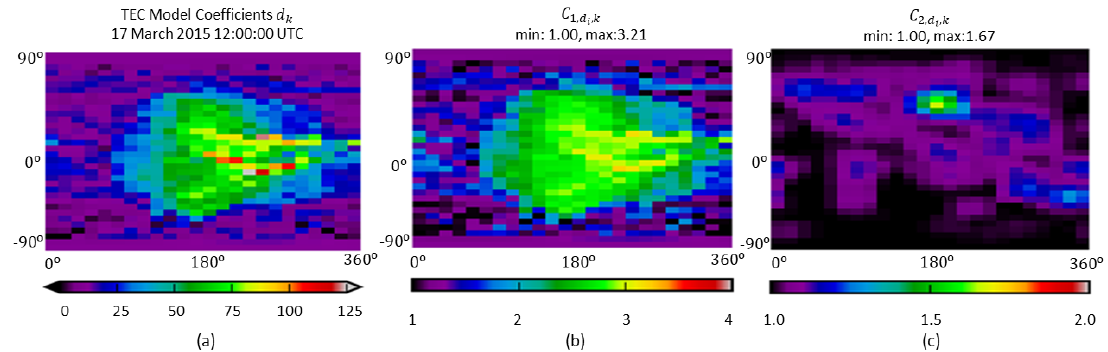
Figure 3. Exemplary process noise parameters; ( a ) Distribution of the B-spline coefficients on 17 March 2015, 12:00 UTC, and the maps of the corresponding process noise parameters for the coefficients C 1, d ( b ) and C 2, d ( c i , k